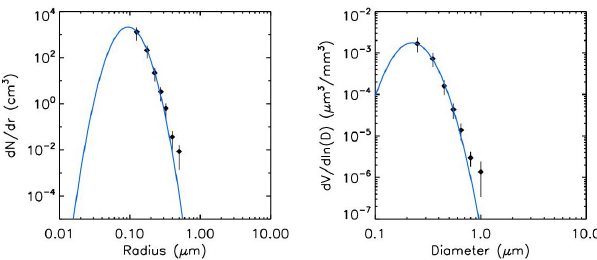
Figure 9. Number (dN / dln(D)) and volume concentration (dV / dln(D)) obtained from LOAC OPC observations